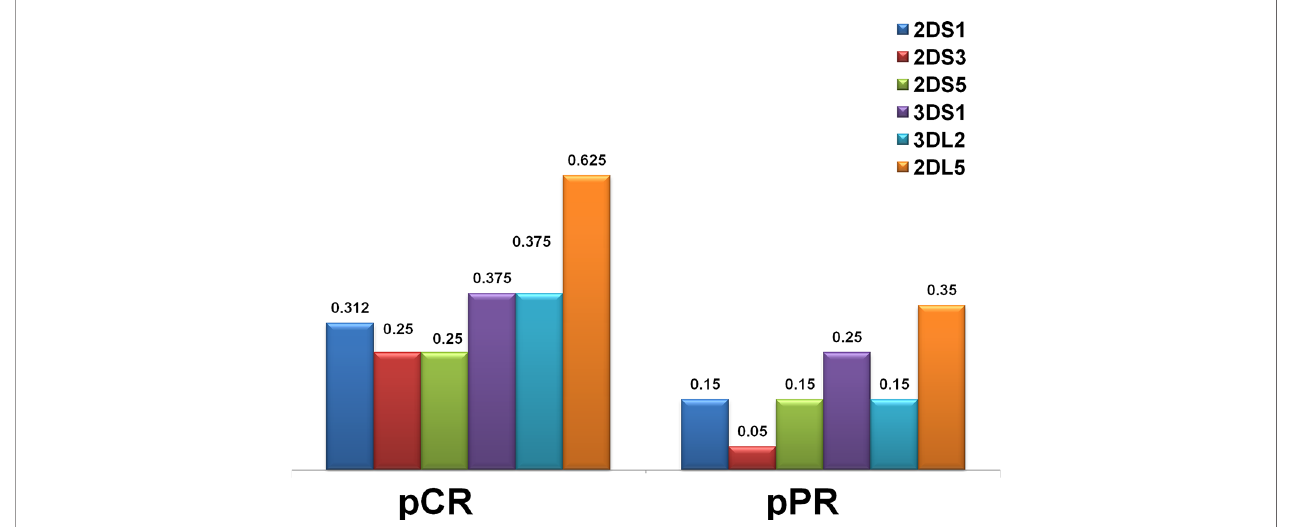
FIGURE 2 | Distribution of KIR genes by frequency in the HER2-positive breast cancer in complete (pCR) and partial (pPR) response to neoadjuvant chemotherapy. The frequency of KIR activators (2DS1, 2DS3, 2DS5, 3DS1) was higher in patients who had a pCR. Framework gene KIR 3DL2, as well as a unique inhibitory KIR 2DL5 gene for which a de fi nite ligand is still unknown, were also more frequent in the pCR